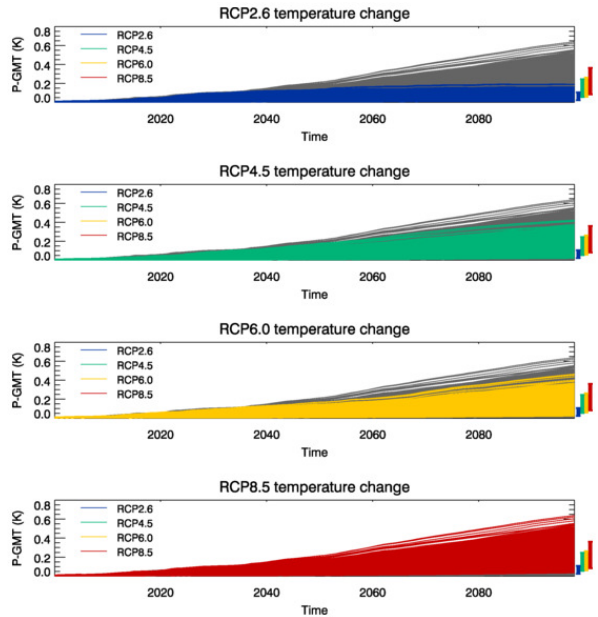
Figure 7. Time series of the temperature change caused by the permafrost CO 2 and CH 4 Fig. 7. Time series of the temperature change caused by the per- mafrost CO 2 and CH 4 emissions for the 4 RCP scenarios (P-GMT). emissions for the 4 RCP scenarios (P-GMT). The bars at the right hand side show the 5 th - The bars at the right-hand side show the 5th–95th percentile values. 95 th percentile values.